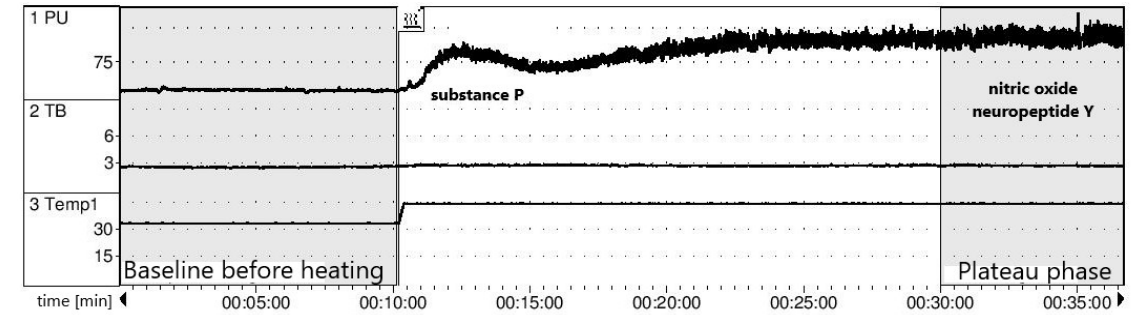
Figure 3. The Laser Doppler Flowmetry (LDF). Abbreviations : PU: perfusion unit; TB: total backscat- ter (the amount of light returned to the detector), Temp1: temperature of the probe 33–44 °C.